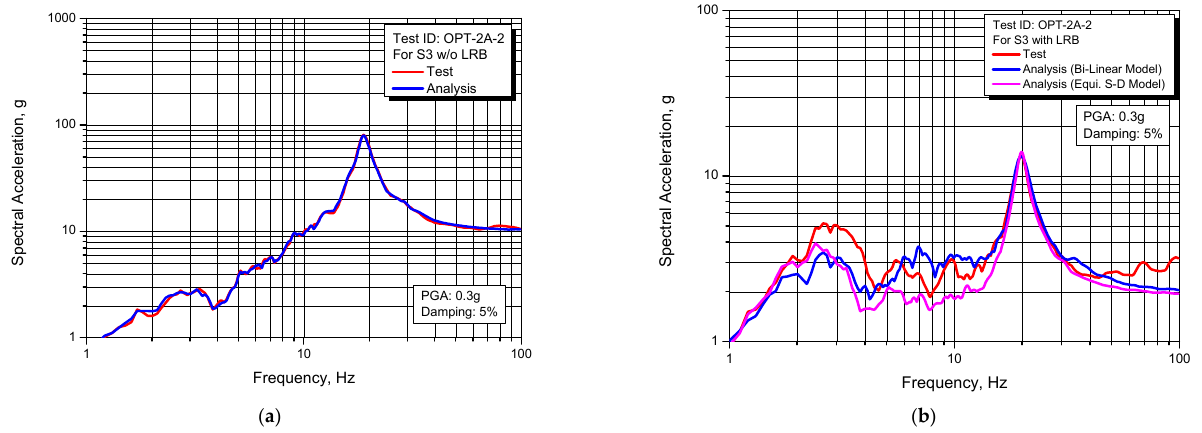
Figure 21. Comparison of response spectrum between test and analysis for S3 structure: ( a ) Non-Isolated; ( b ) Seismically Isolated.